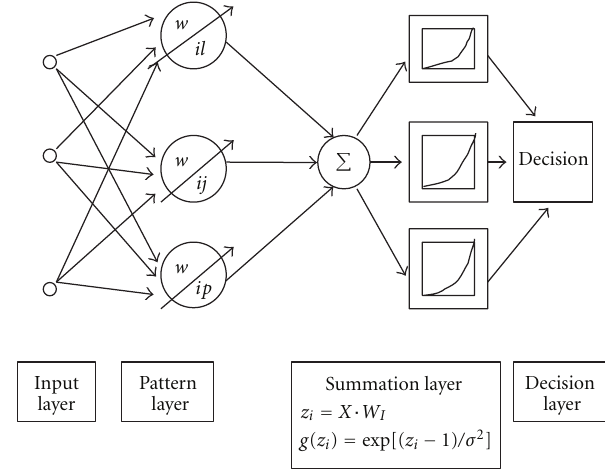
Figure 2: Normalization in a pattern unit: original